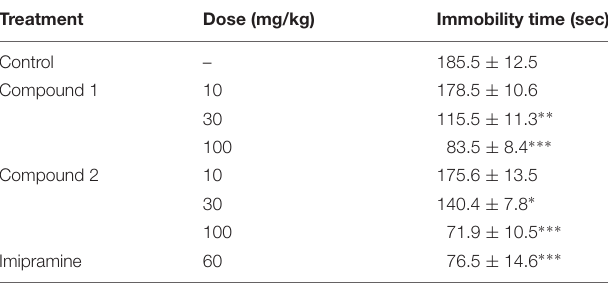
FIGURE 2 | Important HMBC ( −→ ) correlations.